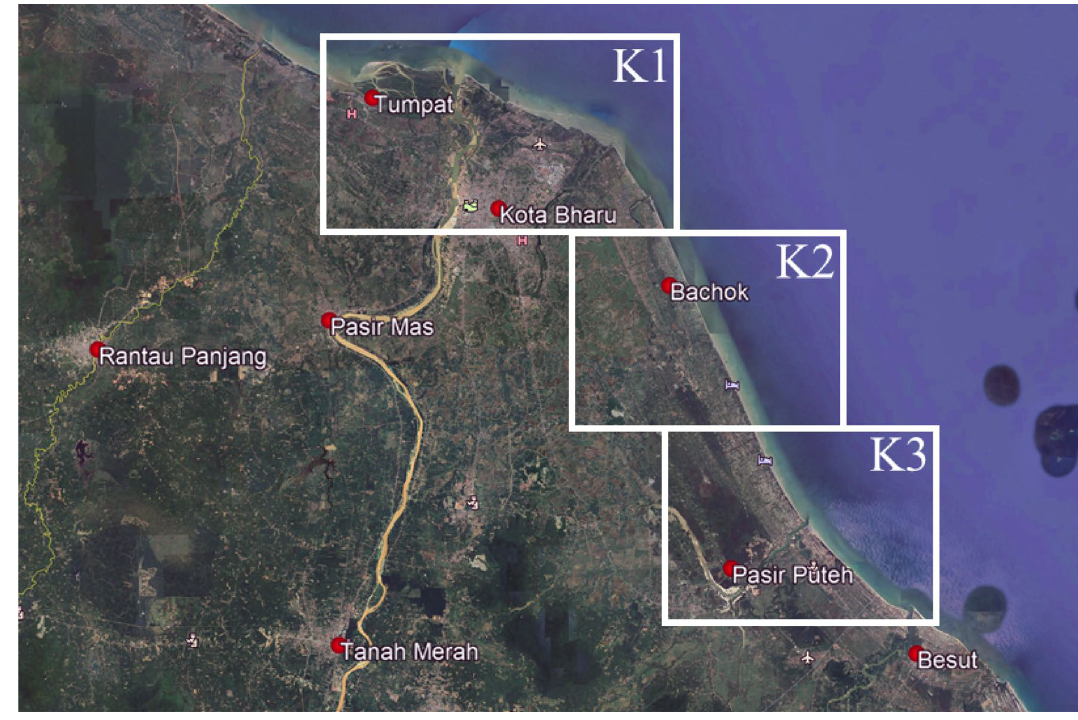
Fig. 5 Parcels (K1–K3) of inundation map in Kelantan